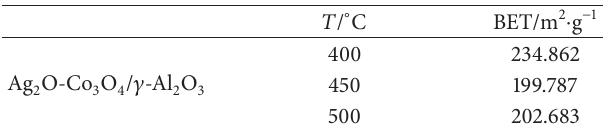
Table 1: The catalyst surface area of different silver calcination temperatures.